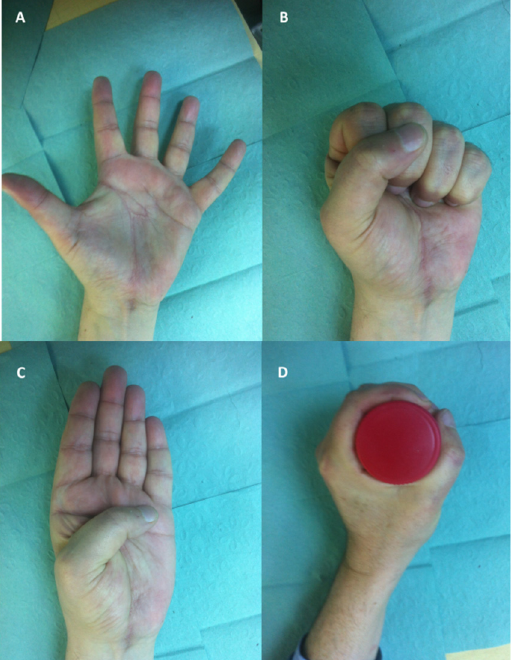
Figure 8. Functional and aesthetic outcomes after giant midpalmar lipoma excision and recon- struction of the 5th deep flexor: ( A ) flexion, ( B ) extension, ( C ) Kapandji score of 10, and ( D ) power grip.